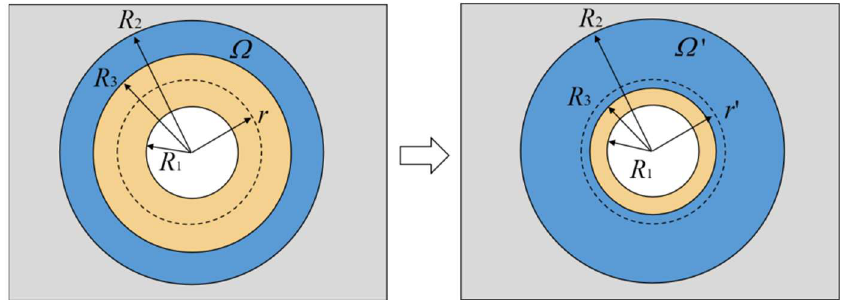
Figure 2. Schematic of an intermediate coordinate transformation process for the thermal concentration meta-structure.